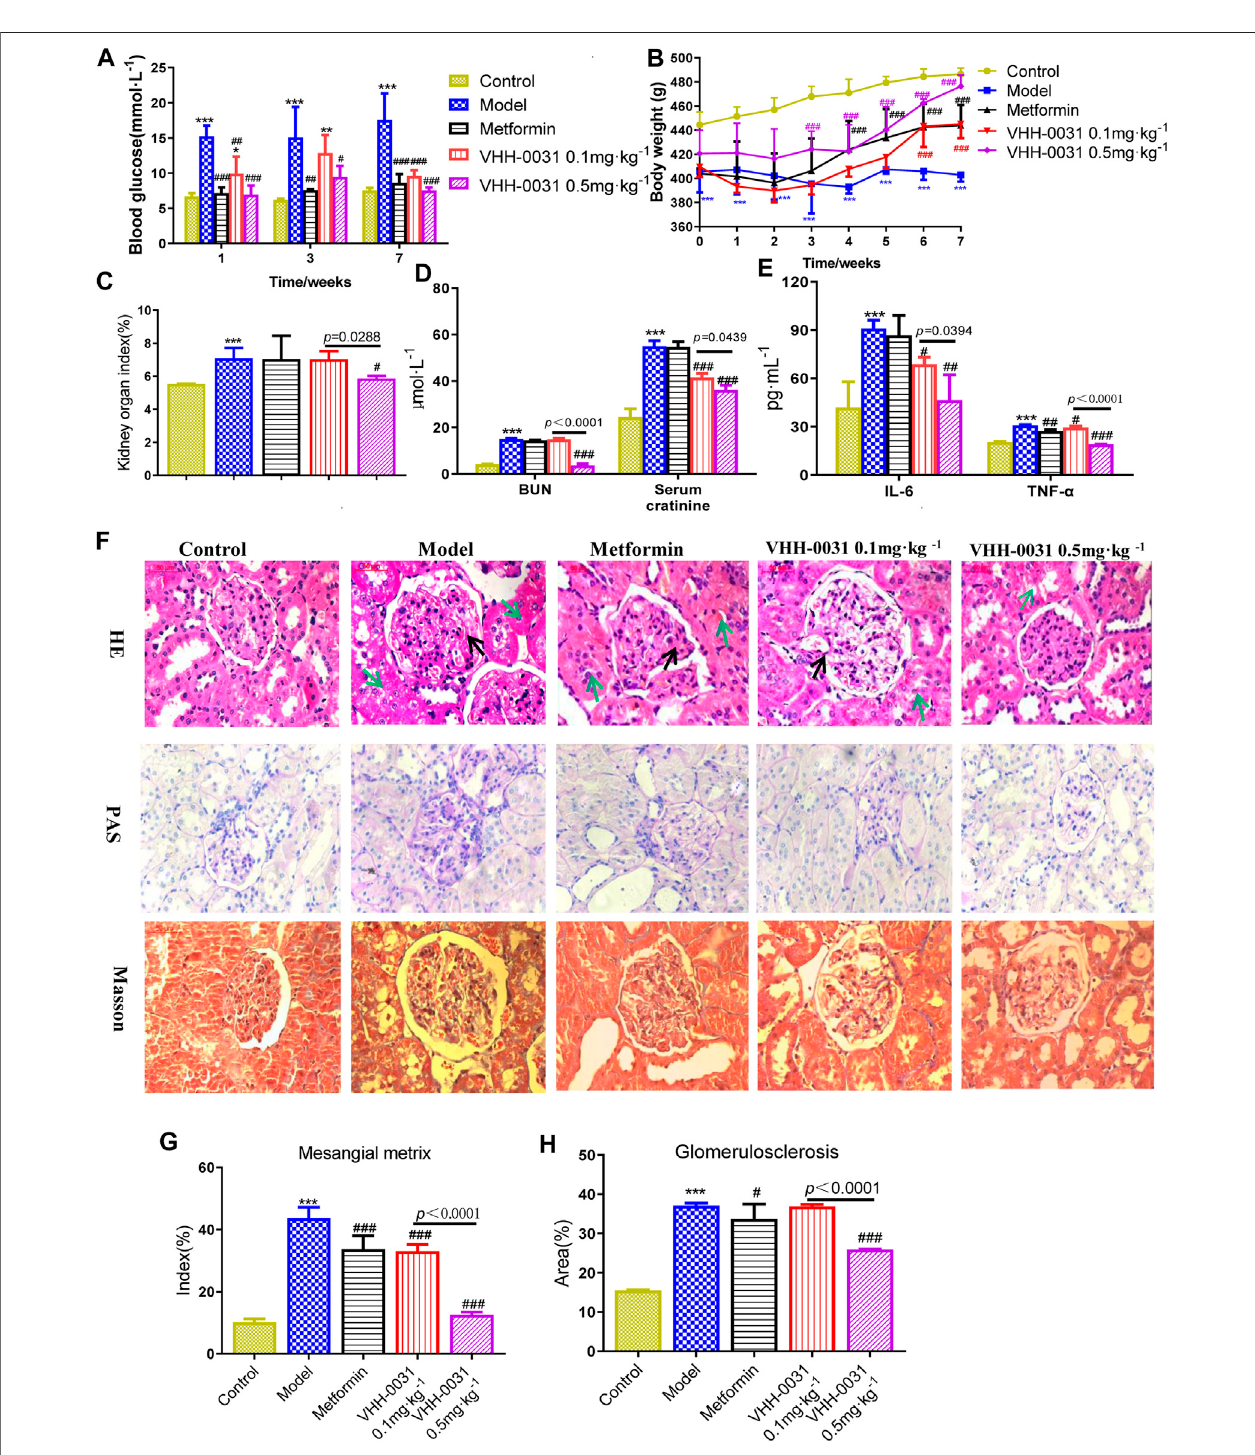
FIGURE1| TheDNpreventioninGKratsbyVHH-0031.Ratswereinjectedwithsaline,metformin(500 mg kg − 1 ),VHH-0031(0.1or0.5 mg kg − 1 )for7 weeks,and then killed for study (A) Blood glucose level, (B) Body weight change (C) The ratio of kidney weight to body weight (D) The level of blood urea nitrogen and serum creatinine in the serum by experimental kit (E) The level of IL-6 and TNF- α in the serum by ELISA (F) Evaluation of mesangial expansion, mesangial metrix caused by glycogen stimulation and glomerulosclerosis caused by collagen deposition in the kidney by H&E, PAS, Masson staining, Bar (cid:1) 100 μ m. The black arrow points to glomerular mesangial hyperplasia, the green arrow points to renal tubule congestion and edema. Quanti fi cation analysis of mesangial matrix index by PAS staining (G) and glomerulosclerosis by Masson ’ s trichrome staining (H) in kidneys. Control: Wistar rats, Model: GK rats, Metformin: GK rats treated with metformin 500 mg kg − 1 , VHH-0031 0.1 and 0.5 mg kg − 1 : GK rats treated with the recombinant anti-IL-6R fusion proteins (0.1 and 0.5 mg kg − 1 ). Data represents the mean ± SD for six rats per group. * p < 0.05, ** p < 0.01, *** p < 0.001 vs control group. # p < 0.05, ## p < 0.01, ### p < 0.001 vs model group.